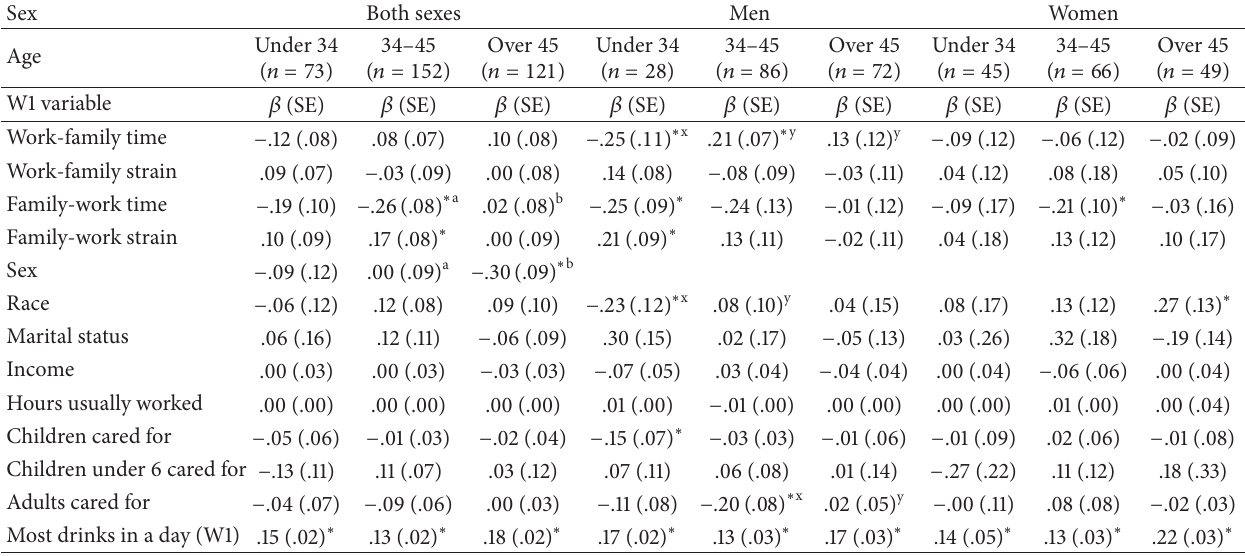
Table 3: Unstandardized regression results predicting most drinks in a day